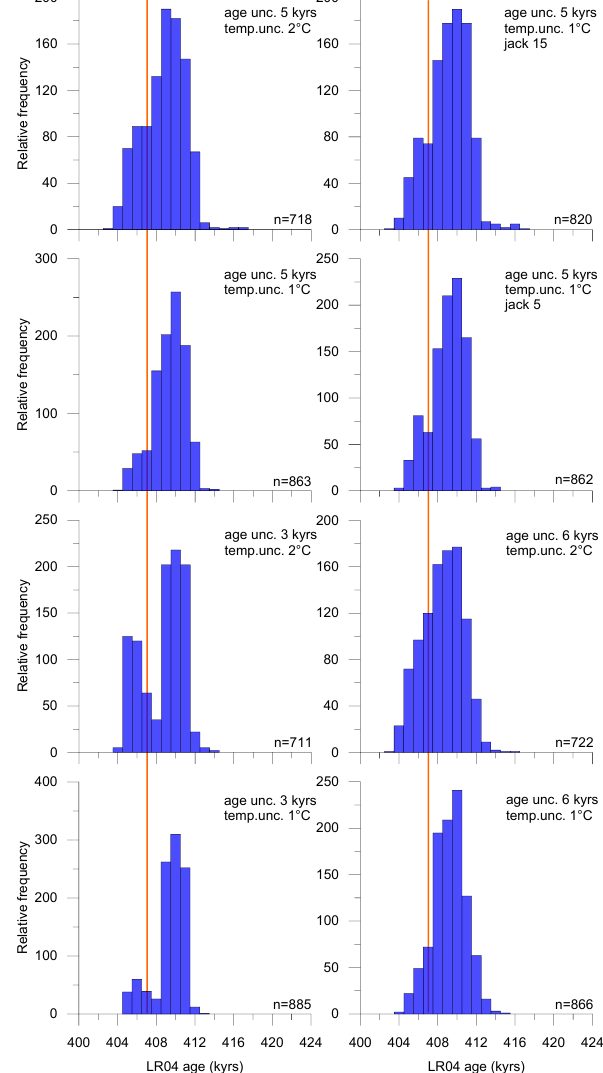
Fig. 10. Sea surface temperature optima during MIS11 calculated with various EOF analyses based on age and temperature uncer- tainties of 3–6ka and 1–2 ◦ C, respectively, and jackknifing versus temperature optimum observed in Antarctica (Jouzel et al., 2007) showing a lag of ∼ 4kyr between the SST optimum calculated with EOF1 and the Antarctic temperature optimum during MIS11. Most EOF runs (74–89%) given here as numbers ( n ) show an earlier SST optimum than that recorded in Antarctica. EDC ages of the Antarc- tic temperature record were converted into LR04 ages according to Parrenin et al.